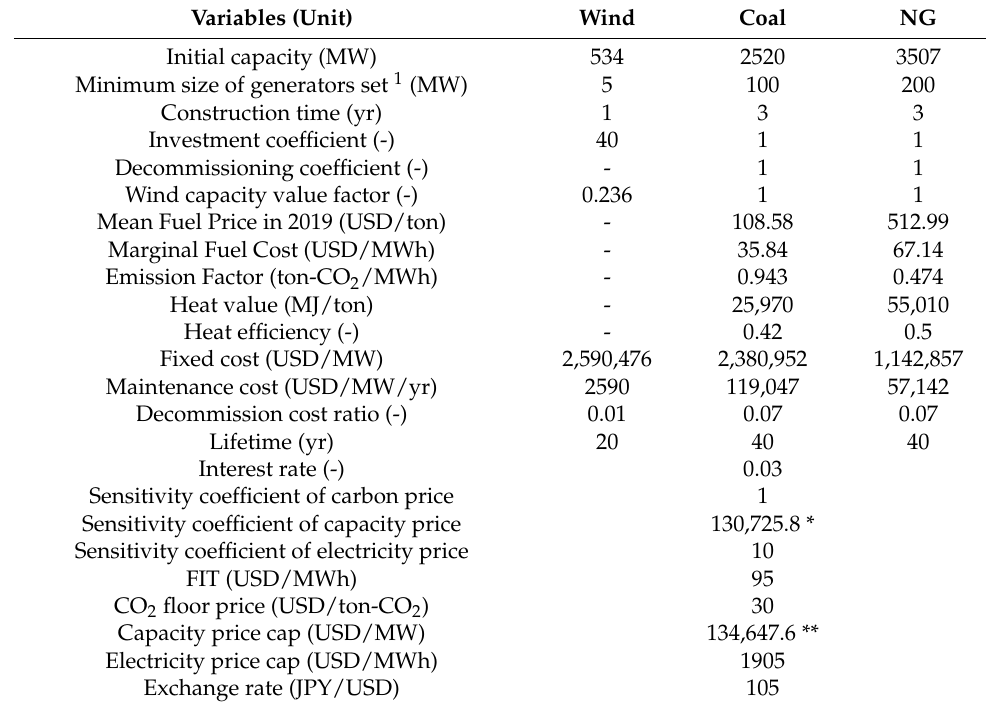
Table 2. Main assumptions and input data related to the case study